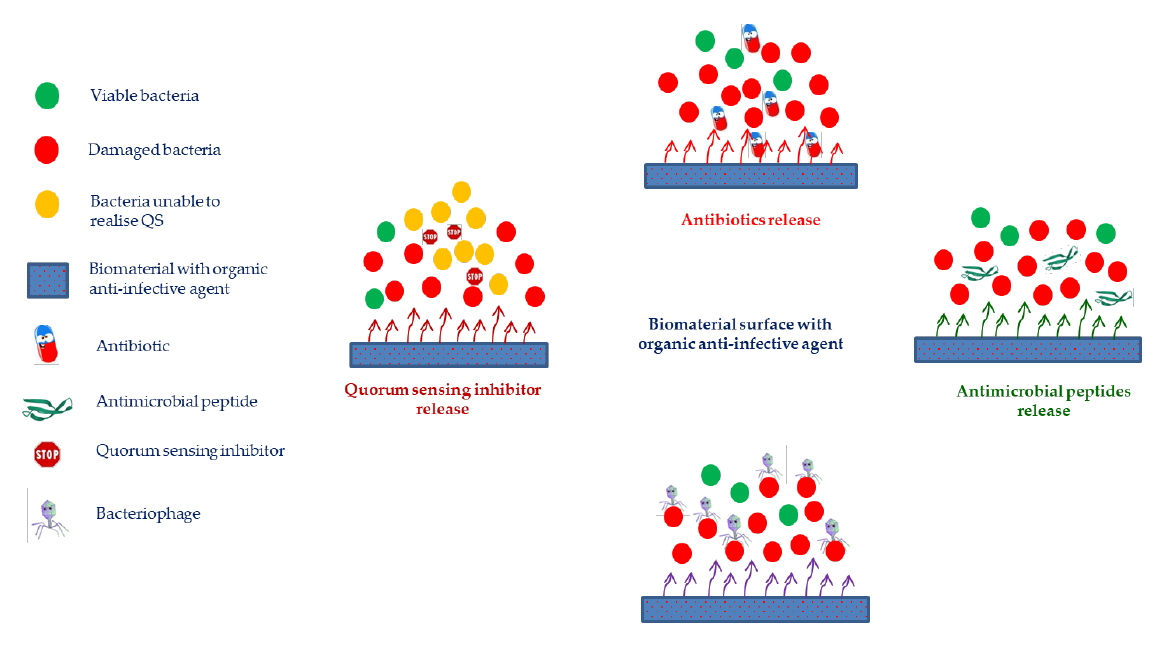
Figure 3. Several strategies developed to trigger antibacterial action in biomaterials involving anti- infective organic agents. infective organic